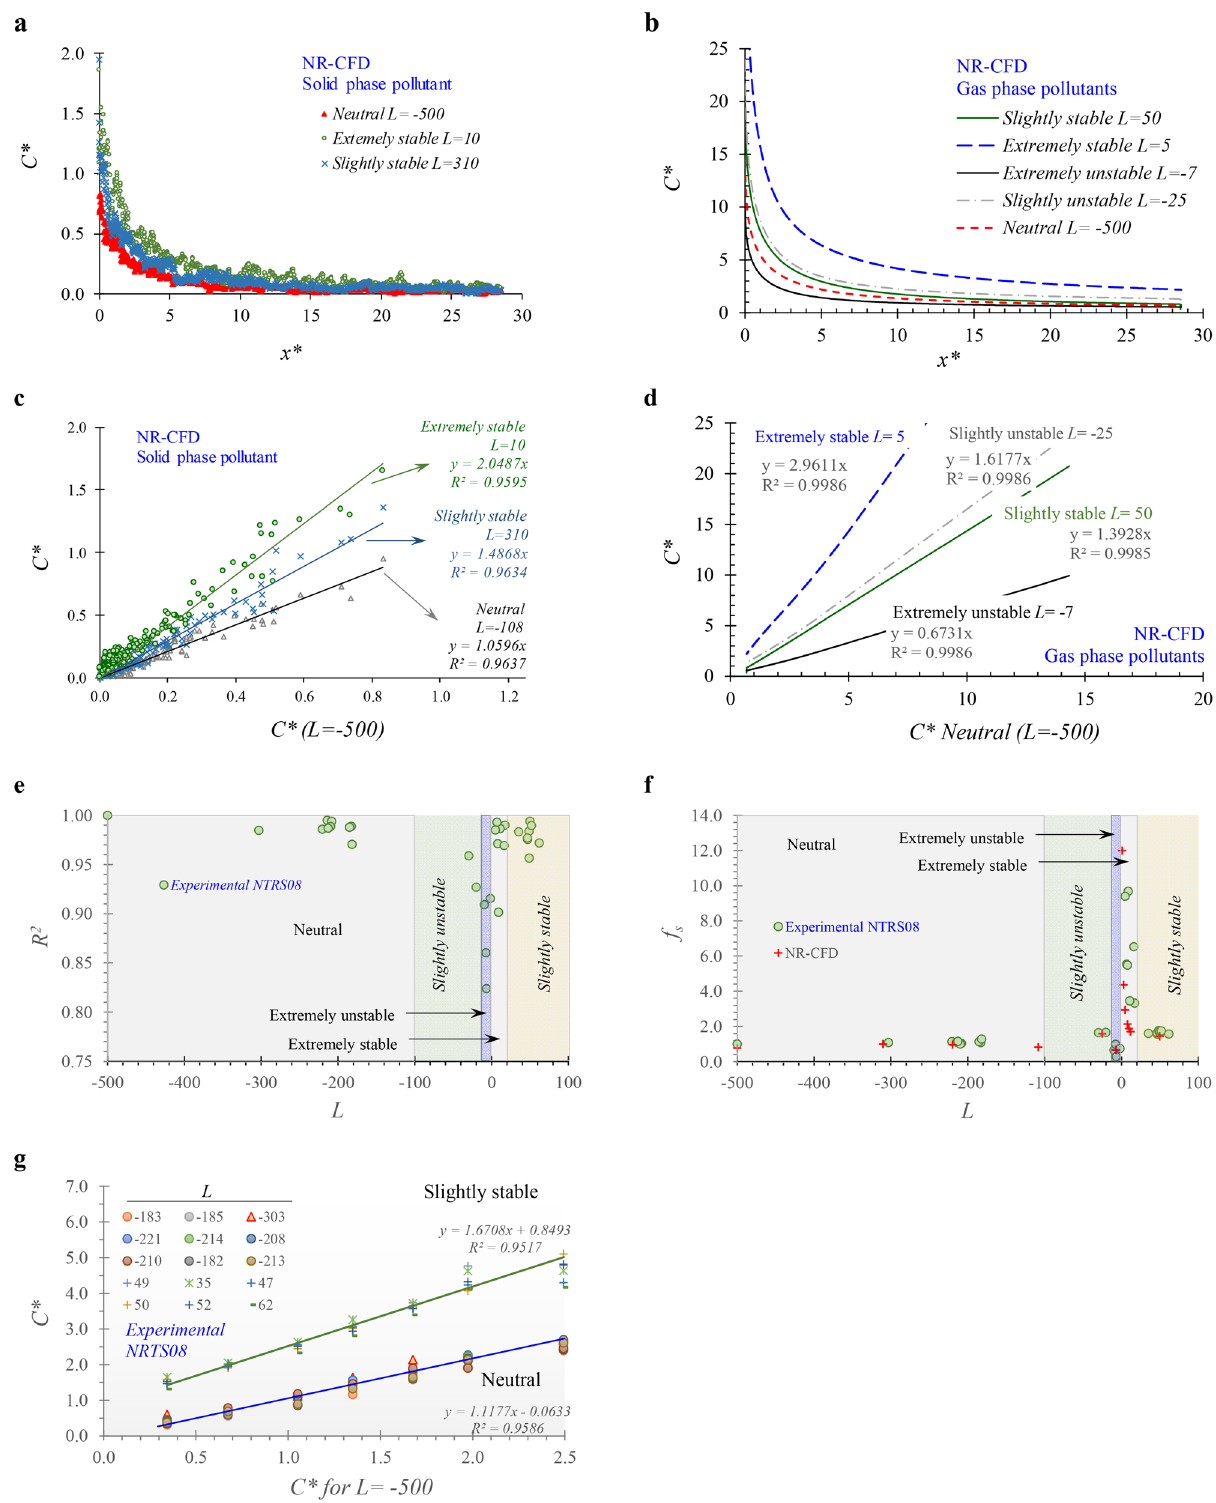
Figure 5. Effects of the atmospheric stability conditions on the dispersion of solid and gas-phase pollutants near roads. C* versus x * profiles for ( a ) solid-phase and ( b ) gas-phase pollutants under different atmospheric conditions; Correlation of the C * obtained under different stability conditions with the C * obtained under neutral conditions for ( c ) TSP and ( d ) gas-phase pollutants; ( e ) Coefficient of determination ( R 2 ) and ( f ) atmospheric stability dispersion factors ( f s ) obtained from the correlation analysis shown in ( d,g ) Correlation analysis among experimental measurements of SF 6 concentrations under neutral and slightly stable